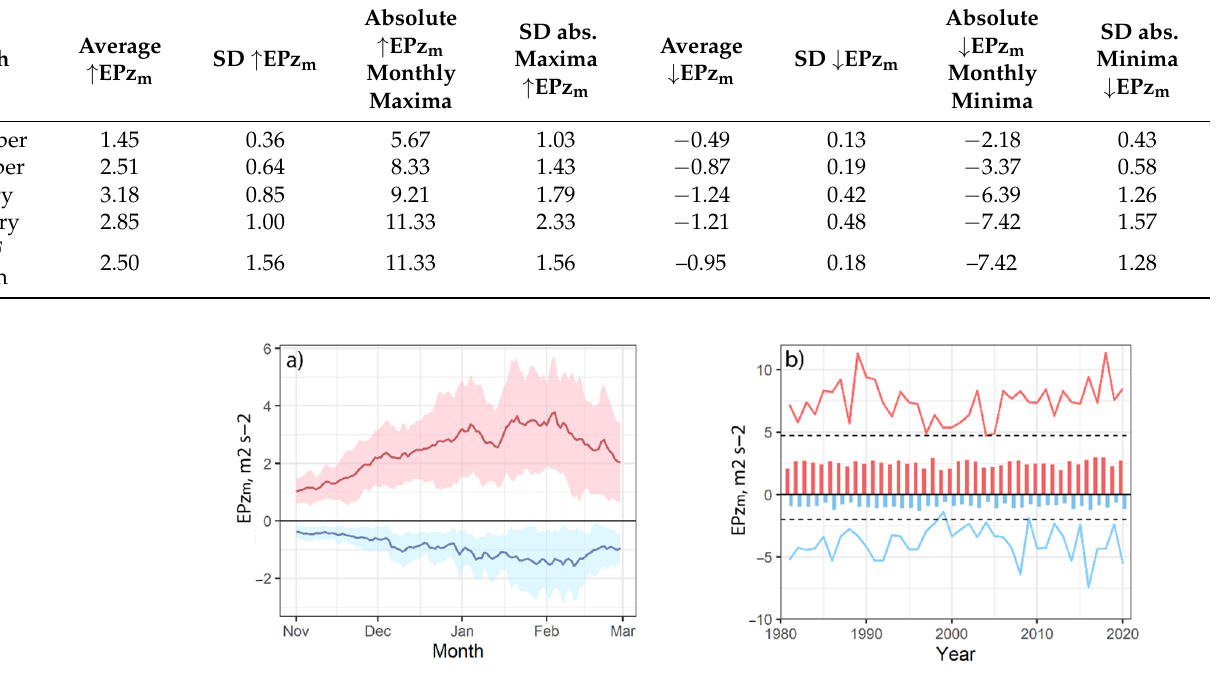
Table 1. The average ↑ EPz m (left) and ↓ EPz m (right) values and their absolute extremes for each month and their standard deviations (SD).